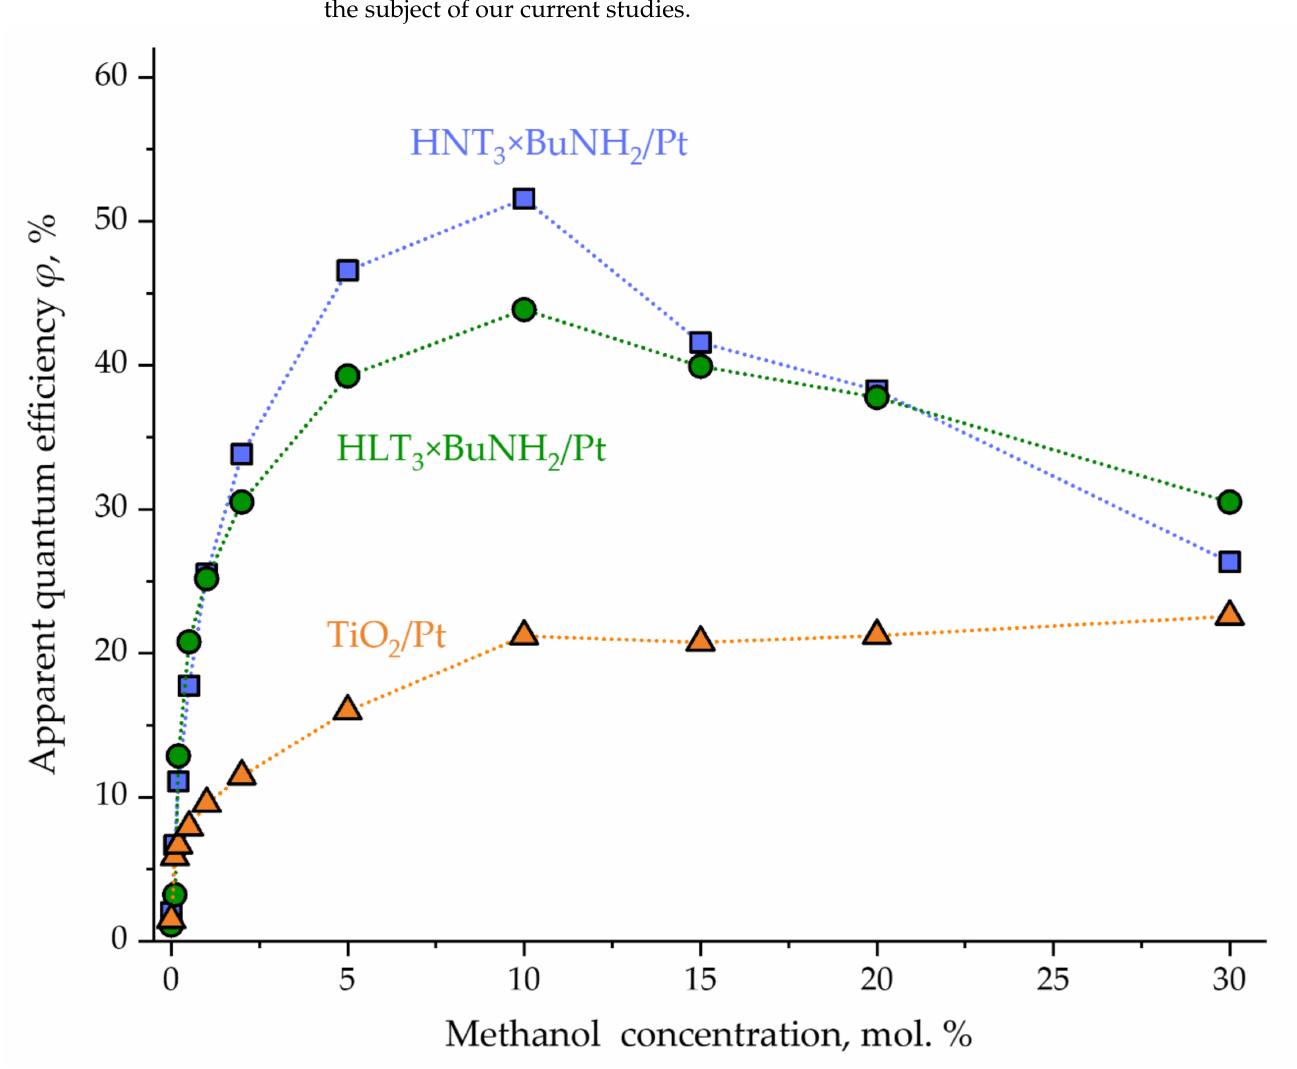
Figure 8. Dependence of apparent quantum efficiency of hydrogen evolution on the methanol concen- tration for the platinized n -butylamine-intercalated titanates HLT 3 × BuNH 2 /Pt, HNT 3 × BuNH 2 /Pt and platinized TiO 2 P25 for